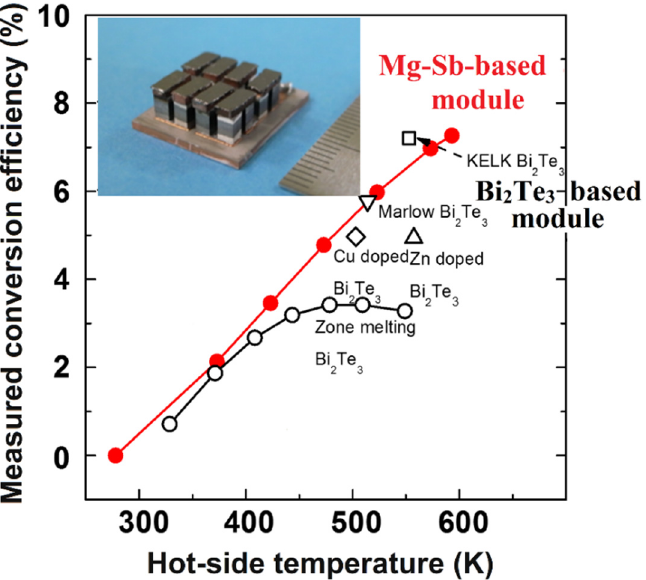
Figure 16. The measured conversion efficiency of eight pairs thermoelectric module of minor Cu- doped Mg 3 (Sb,Bi) 2 -type/MgAgSb-type as a function of hot-side temperature (cold side 278 K) [95].